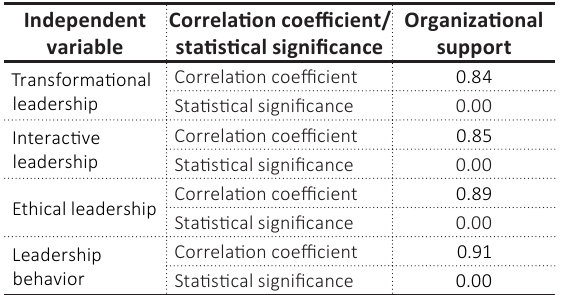
Table 9. Pearson correlation coefficient results for the relationship between organizational support and psychological capital